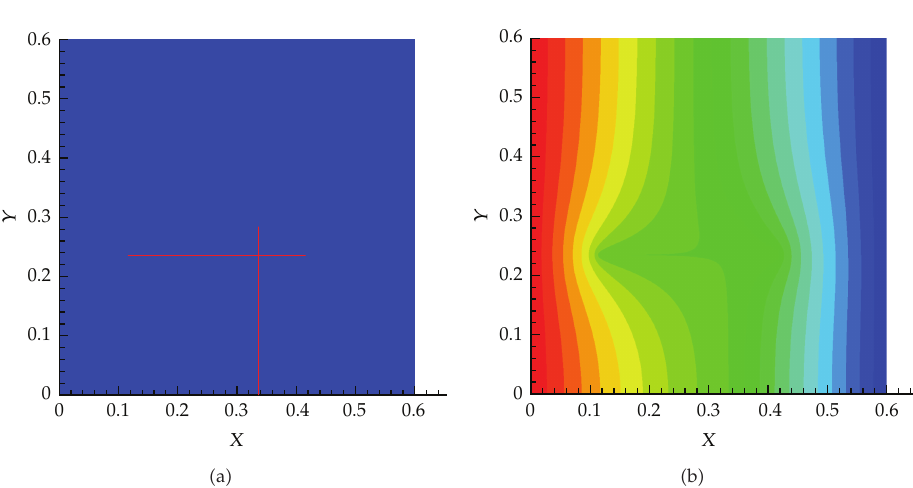
Figure 5: Fractures orientations (cid:2) 2 fractures (cid:3) and pressure contours based on the fine